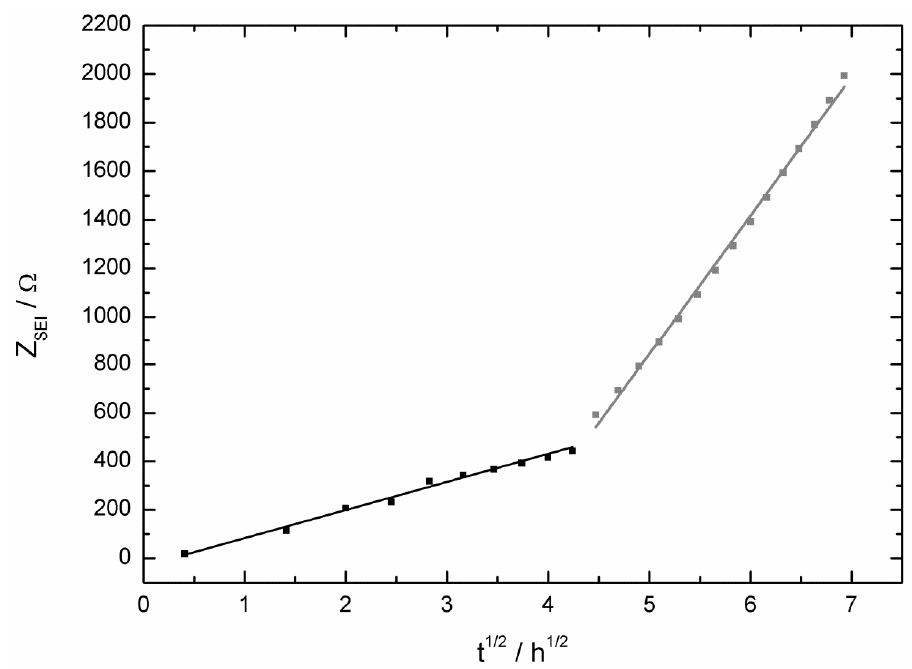
Figure 14. Variation of the interphase resistance Z LiPF in EC:DEC (3:7, by wt.) 6